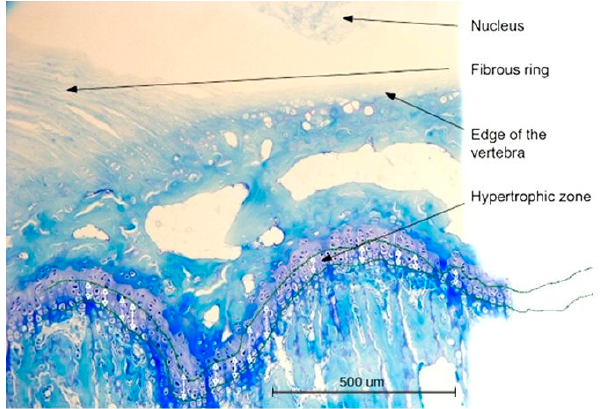
Figure 9. Scheme of hypertrophic zone measurement. Methyl Blue staining 100×.